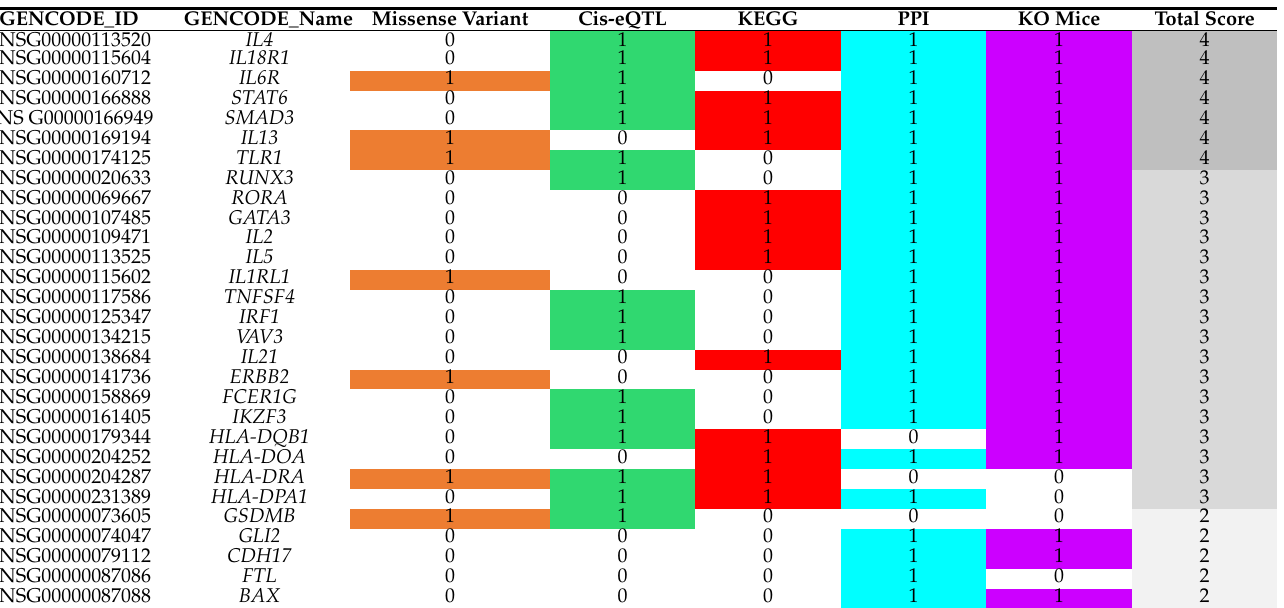
Figure 3. Histogram distribution of gene scores: 460 and 111 genes had scores of 0 and 1, respectively; the 65 genes with total scores ≥ 2 were identified as “depression risk genes”. Table 1. Five functional annotations applied to prioritize the depression risk genes.